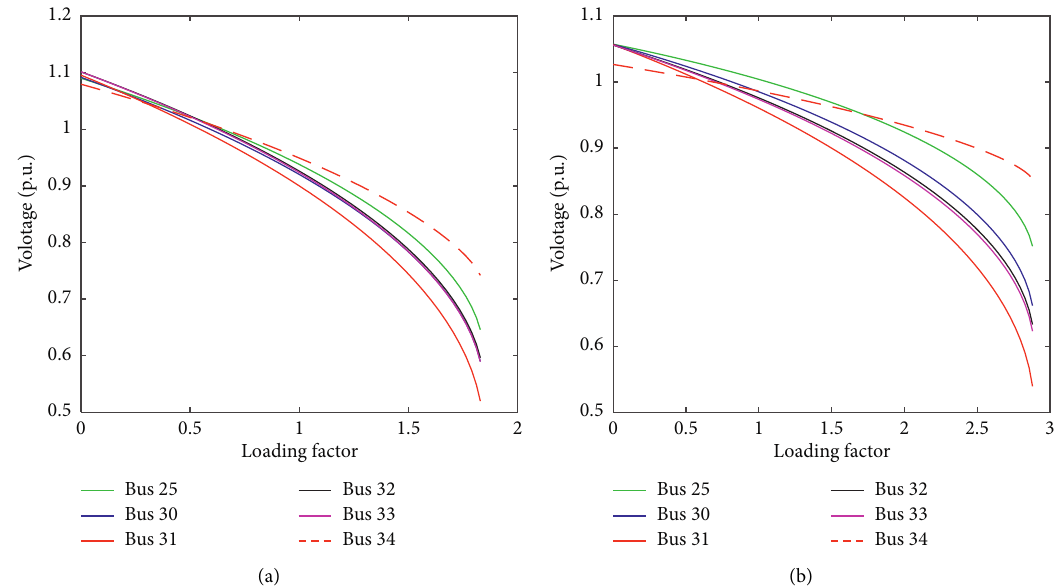
Figure 10: Voltage profile of buses from 25 to 30–34 during the load-increasing process when using MCPF: (a) without DG at buses 26, 39, and 54; (b) with DG at buses 26, 39, and 54.